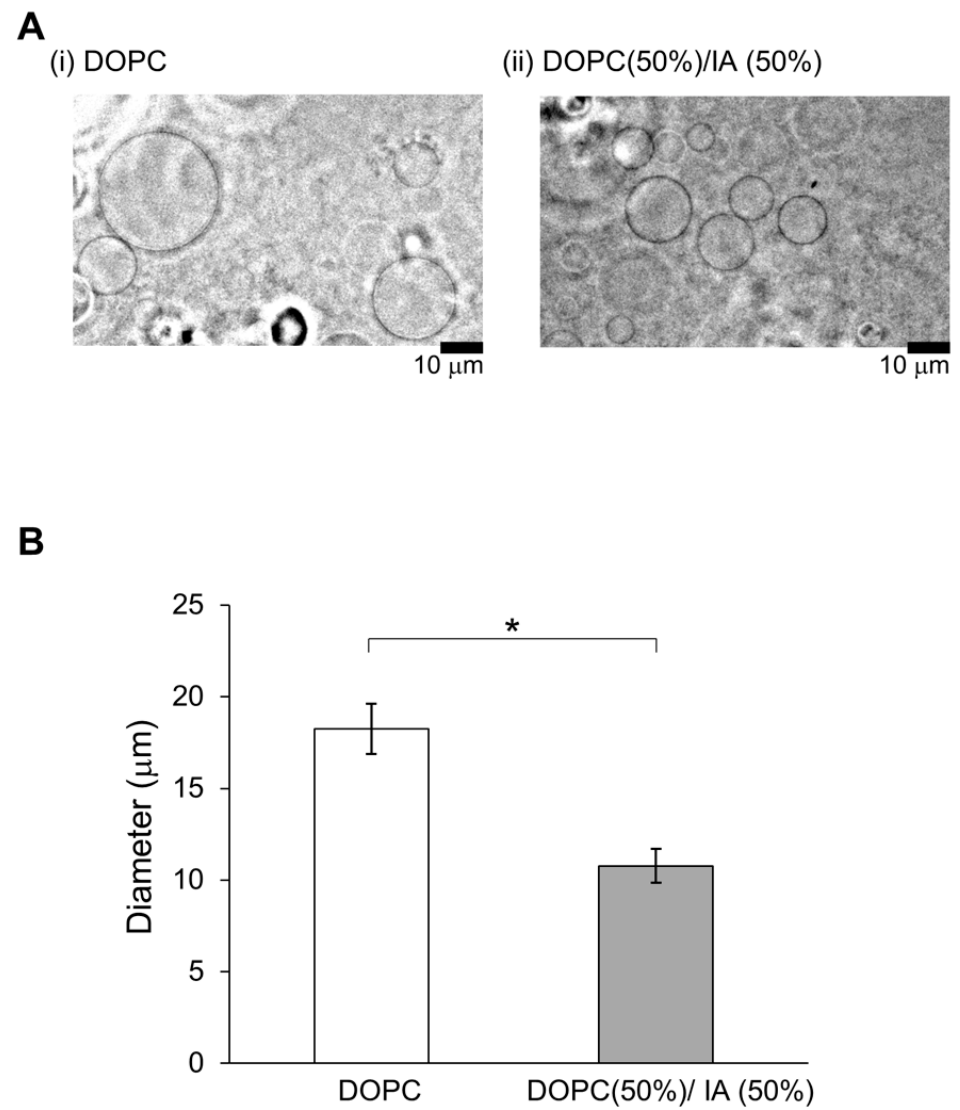
Figure 4. Vesicles containing isoamyl acetate (IA) are smaller. ( A ) Images of typical lipid vesicles captured using a phase-contrast microscope: ( i ) DOPC and ( ii ) DOPC (50%) with IA (50%). Scale bars: 10 µ m. ( B ) Vesicle diameter based on contents: vesicles containing DOPC (white) and vesicles containing 50% DOPC and 50% IA. (* p < 0.05).